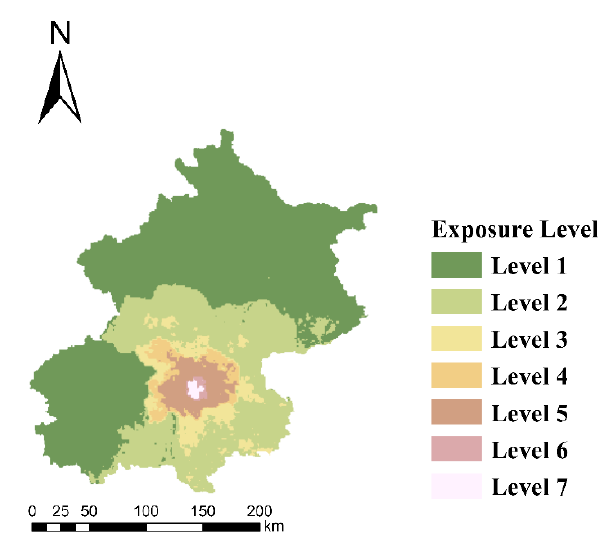
Figure 4. PWE level spatial distribution in autumn and winter of Beijing.